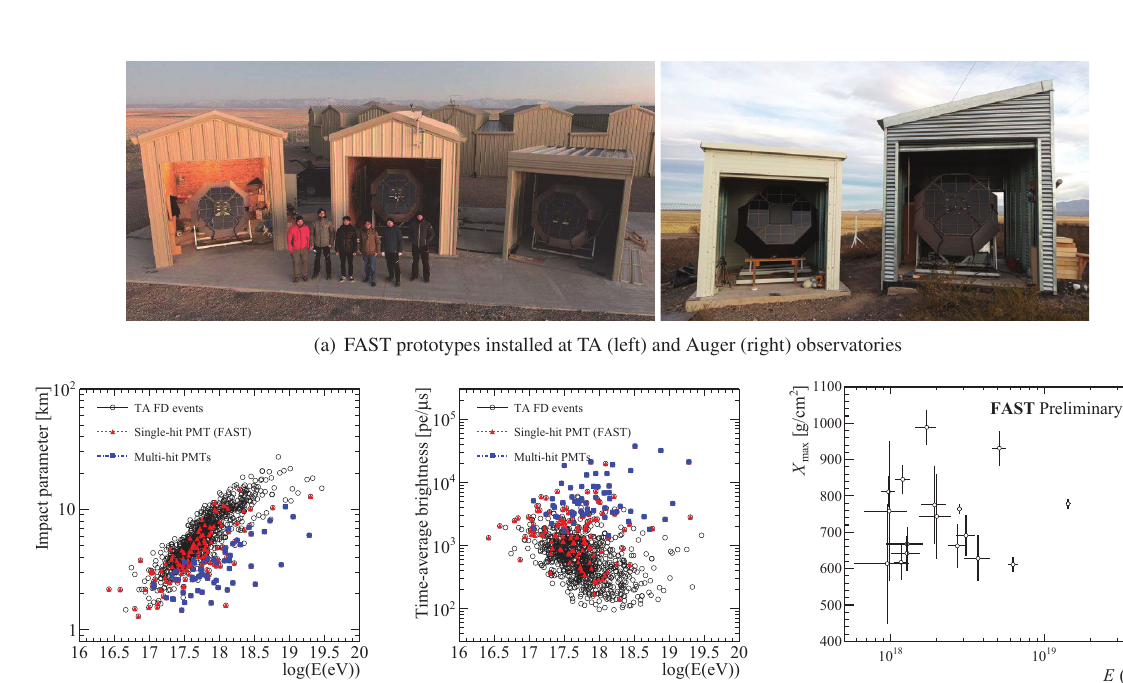
Figure 2. (a) The three FAST prototypes installed at the Black Rock Mesa site of the Telescope Array Experiment and the one prototype installed at Los Leones site of the Pierre Auger Observatory. (b) Impact parameter and (c) time-average brightness for the coincidence search between TA FD and FAST. (d) Preliminary result of top-down Energy and X max reconstructions for multi-hit events above